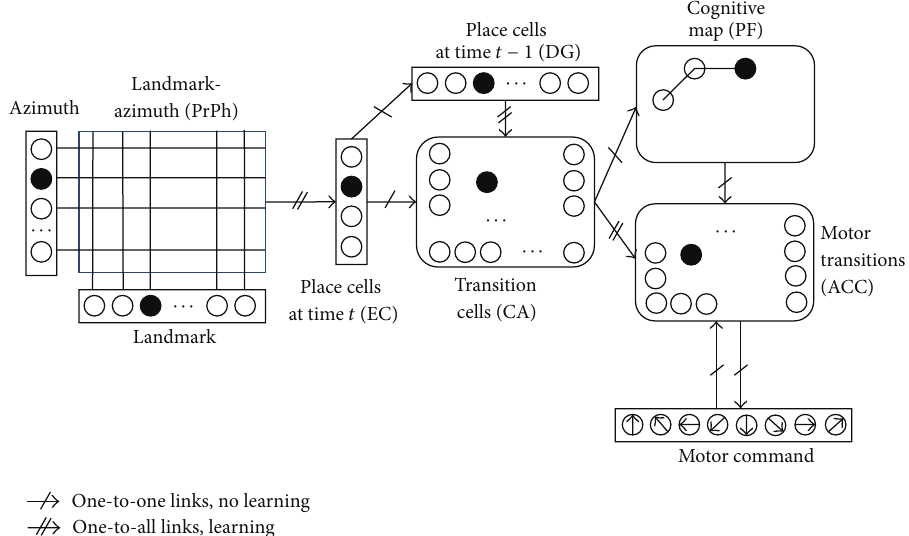
Figure 10: The system’s neural network based model architecture. Processing flow starts at the far left with the input of each camera snapshot